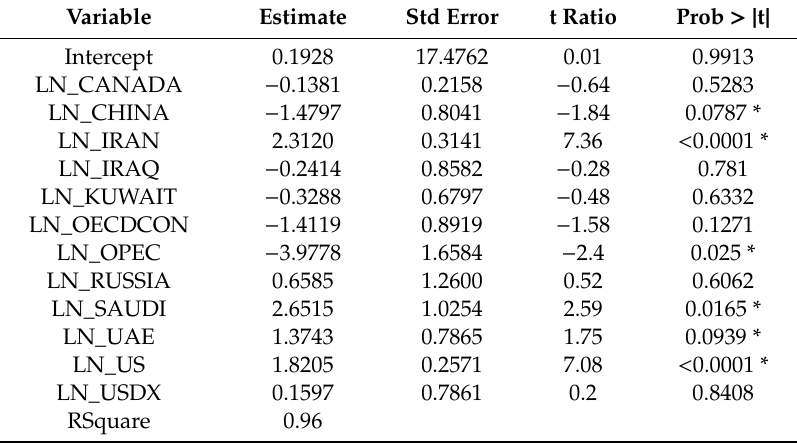
Table 18. Panel 7 period (2016–2018): LN_BRENT prediction-parameter